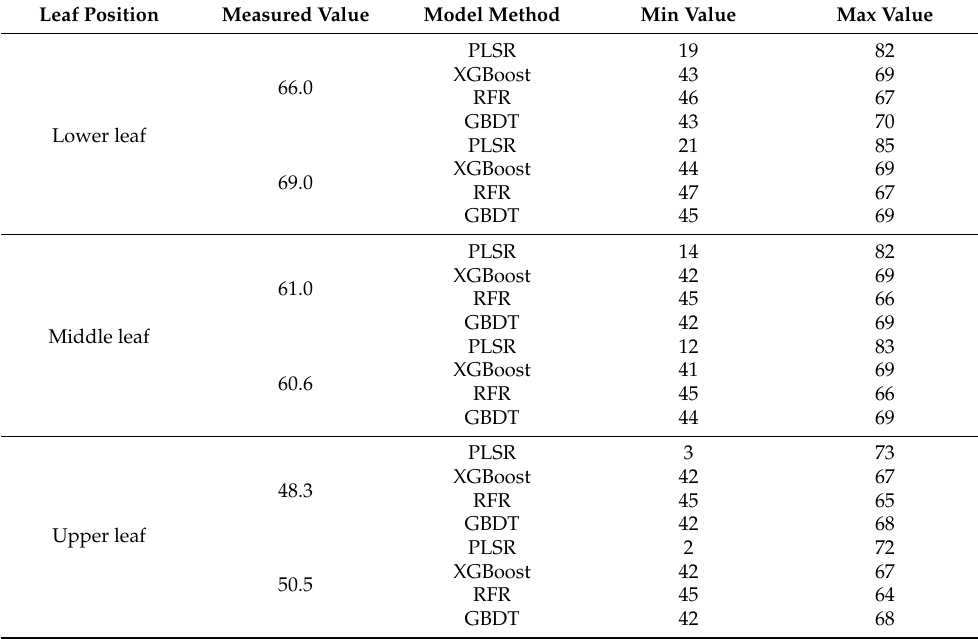
Figure 12. Distribution of SPAD value in the middle leaf in different models: ( a , e —PLSR), ( b , f —XGBoost), ( c , g —RFR), ( d , h —GBDT). Table 3. Statistical information of chlorophyll inversion map of pepper leaves under different models and different leaf